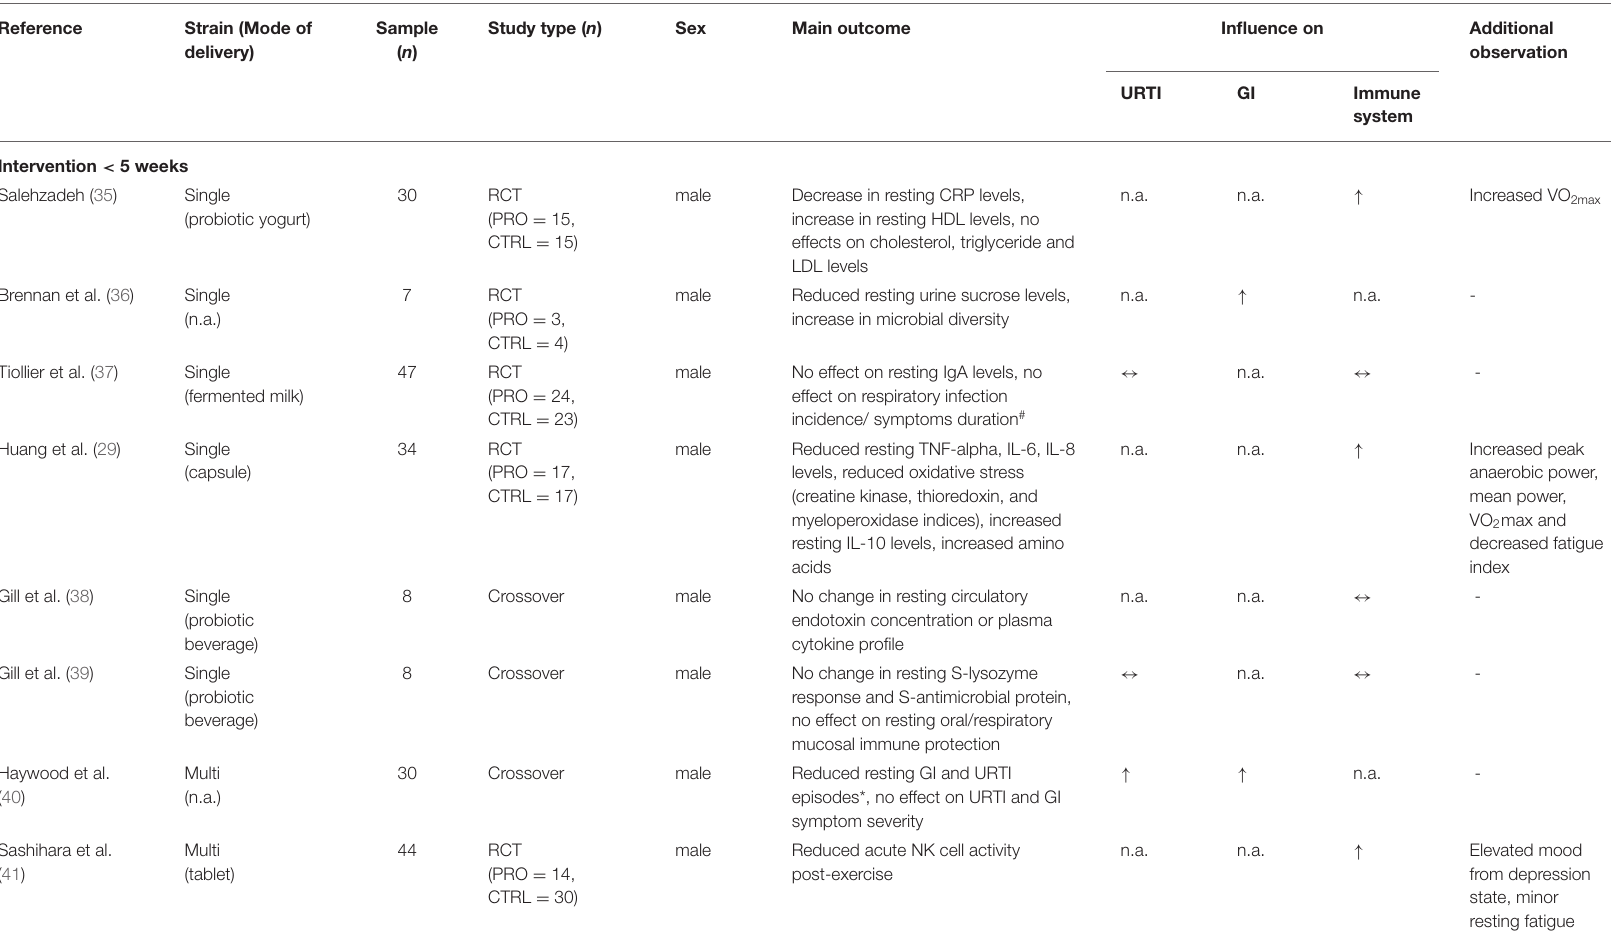
TABLE 2 | Effects of probiotics by performance level and duration of intervention.